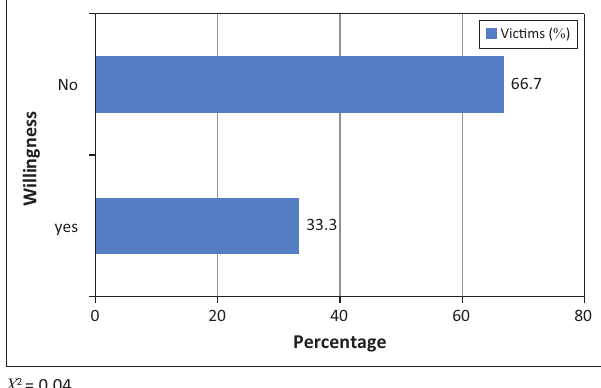
FIGURE 2: Household willingness to self-relocate out of the current disaster zone.